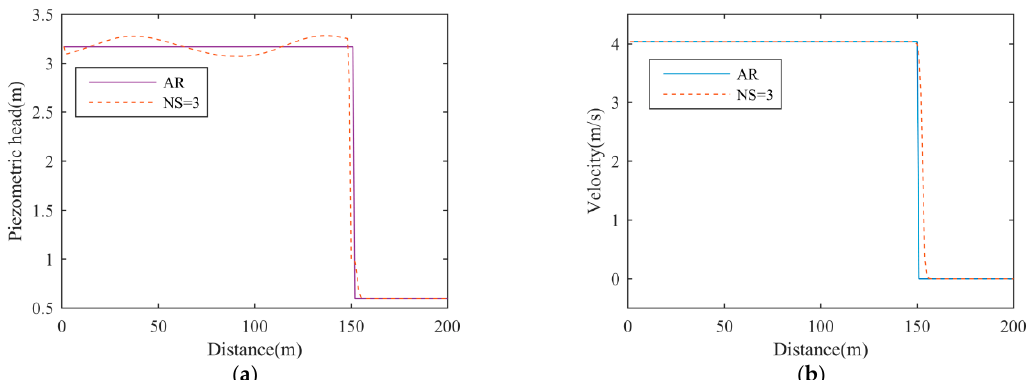
Figure 7. Comparison of the results simulated by M_HLL, with K a = 1.4 and NS = 3, and the analytical result (AR): ( a ) piezometric head; ( b ) flow velocity.